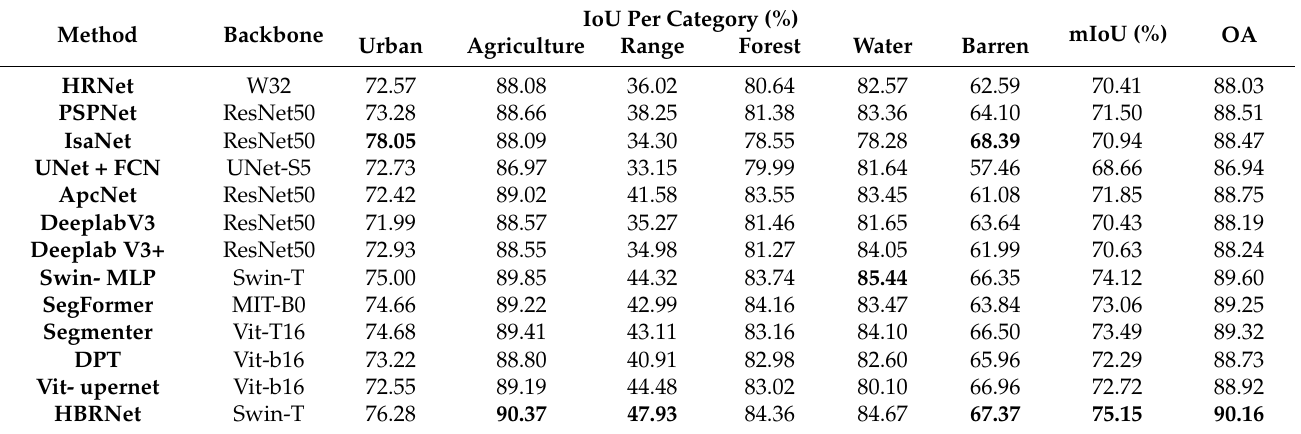
Table 2. Results on the DeepGlobe dataset test set (the result with the highest value is bolded). We employed the overall accuracy (OA), Intersection over Union (IoU) of Per Category and the mean Intersection over Union (mIoU) to evaluate model